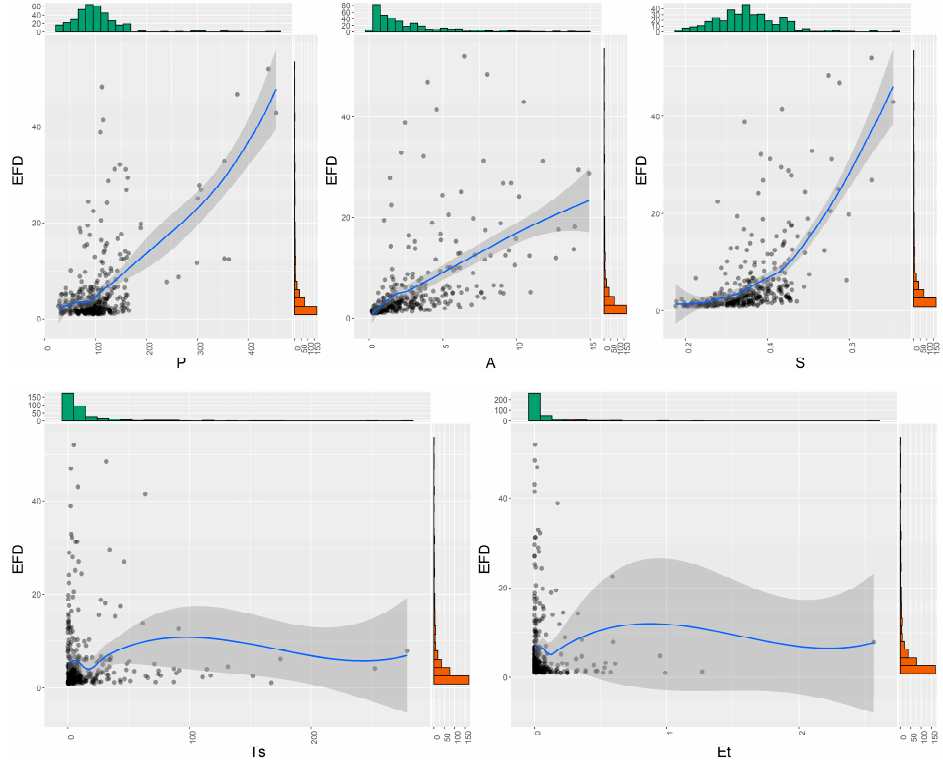
Figure 9. Scatter plots of EFD and factors for 73 counties of Jiangsu in 1995–2015.